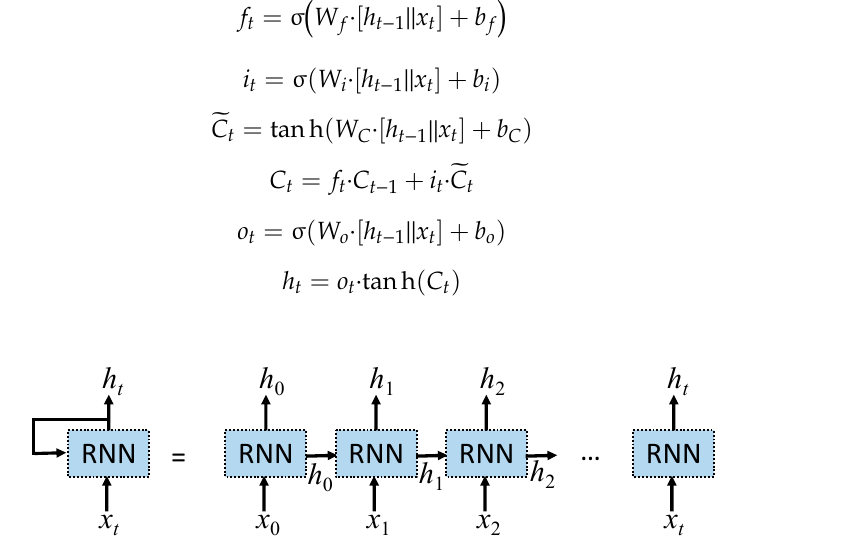
Figure 7. The structure of the RNN ( left ) and its application in processing time series data ( right ).